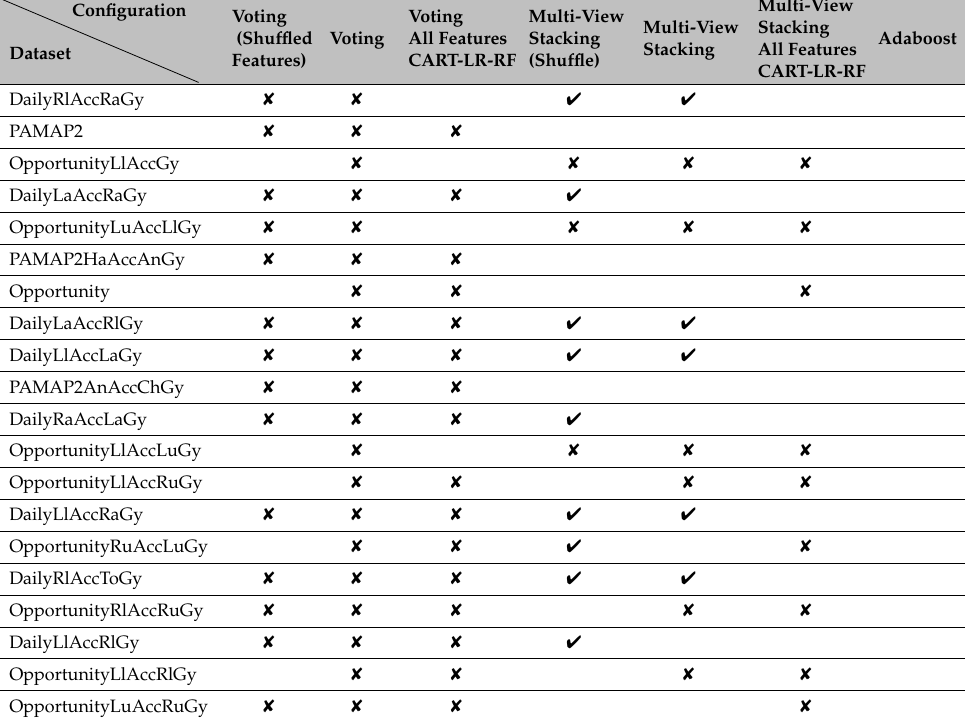
Table 1. Relationship between the configurations of the fusion methods and the datasets, with respect to significant differences found when these configurations mainly used Random Forest as a classifier. DatasetConfiguration Voting